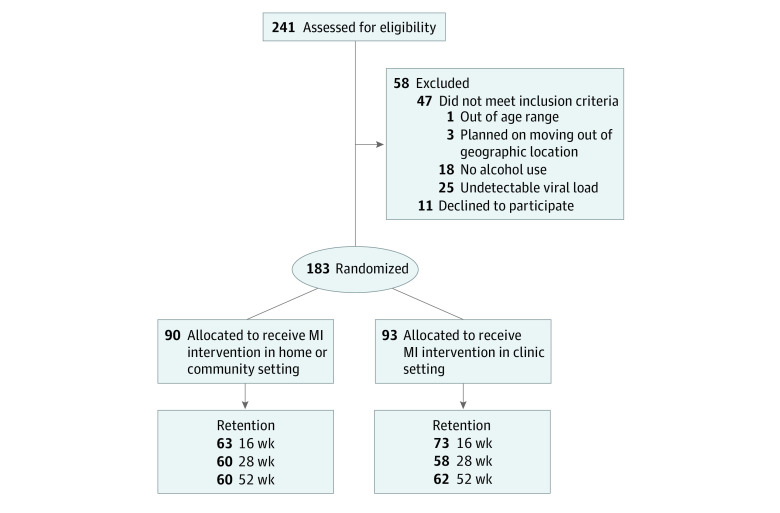
Participant Flow ChartMI indicates motivational interview.